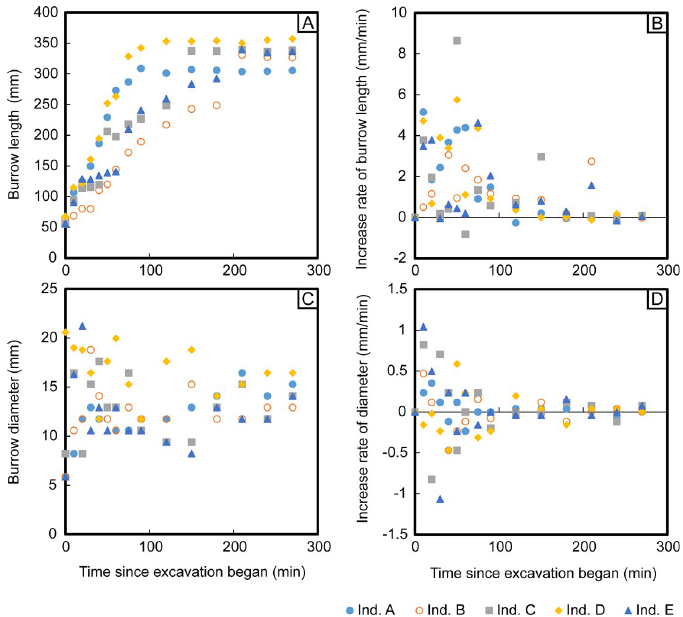
Fig 7. Changes in burrow length and diameter over time. Panels show: (A) length, (B) the rate of increase of length, (C) diameter, and (D) the rate of increase of